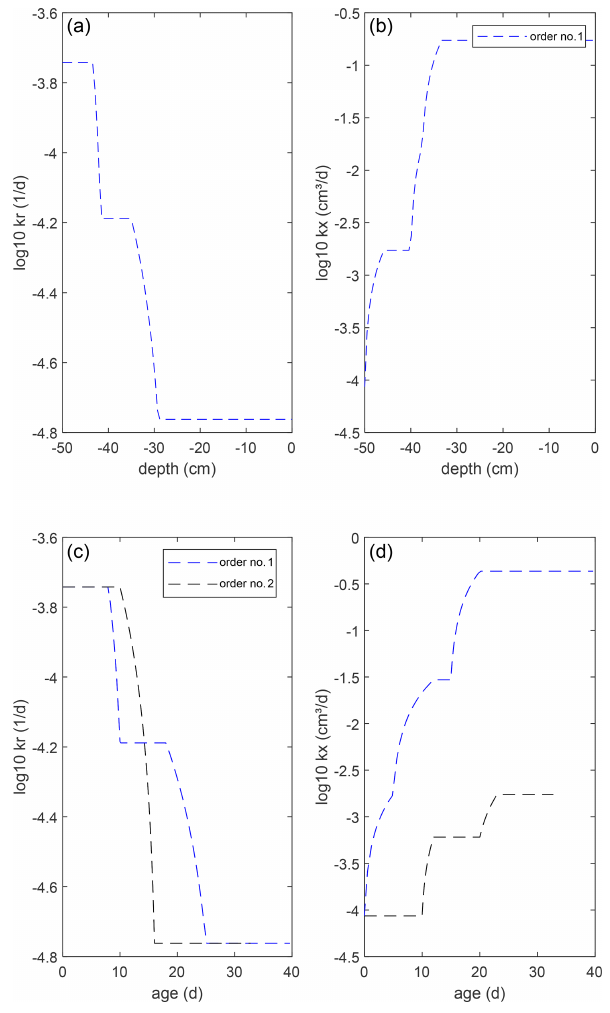
Figure 6. Radial (a, c) , k r , and axial (b, d) , k x , intrinsic root con- ductances for the single root (a, b) and root system architectures (c, d) . For the single root, conductances are plotted versus depth and for the root system architectures versus root segment